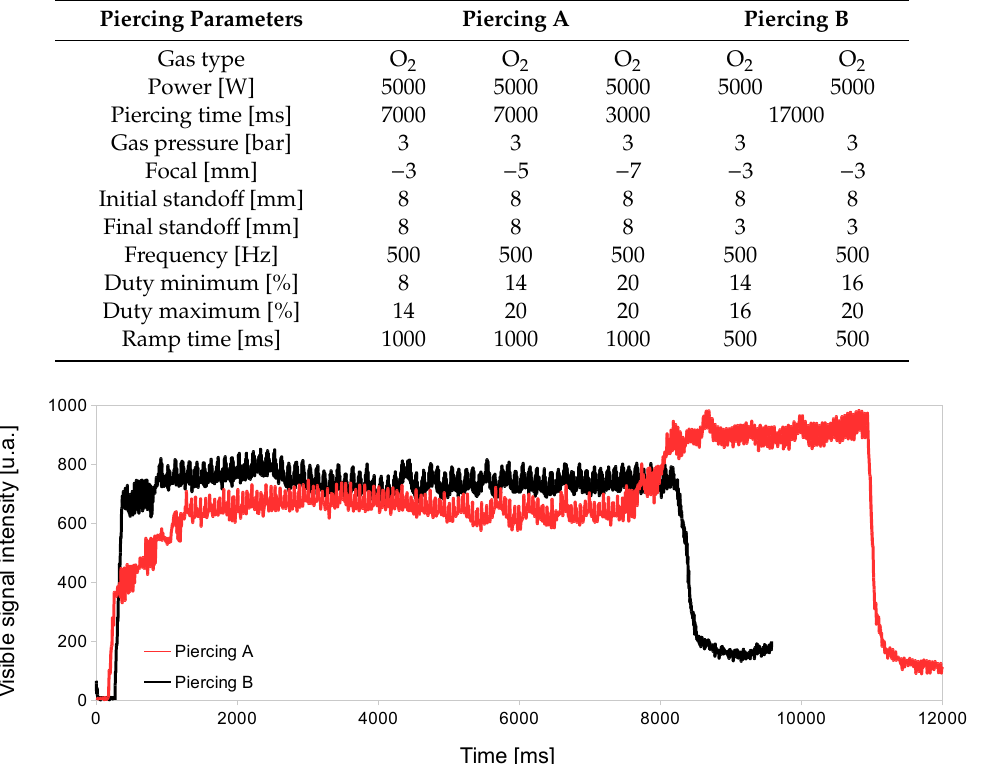
Table 3. Piercing parameters for mild steel 20 mm thick, for two different piercing strategies. Piercing A was programmed as three independent piercings and piercing B as a continuous descendent piercing process.